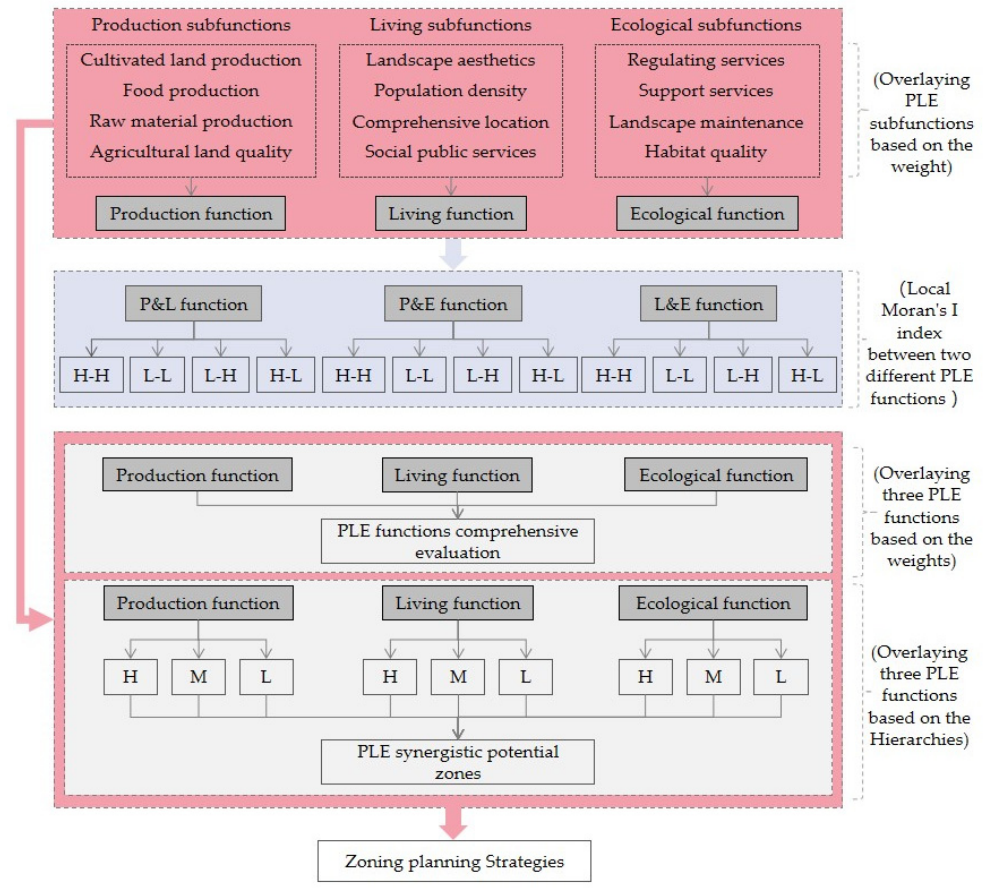
Figure 3. Research framework. (Pink represents the relationship between the three functions of the PLE, and lavender represents the relationship between the two functions of the PLE.)